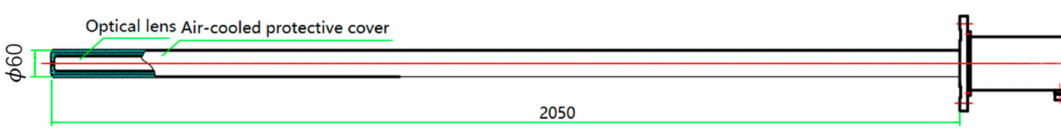
Figure 2. Schematic diagram and dimensions of the cover.